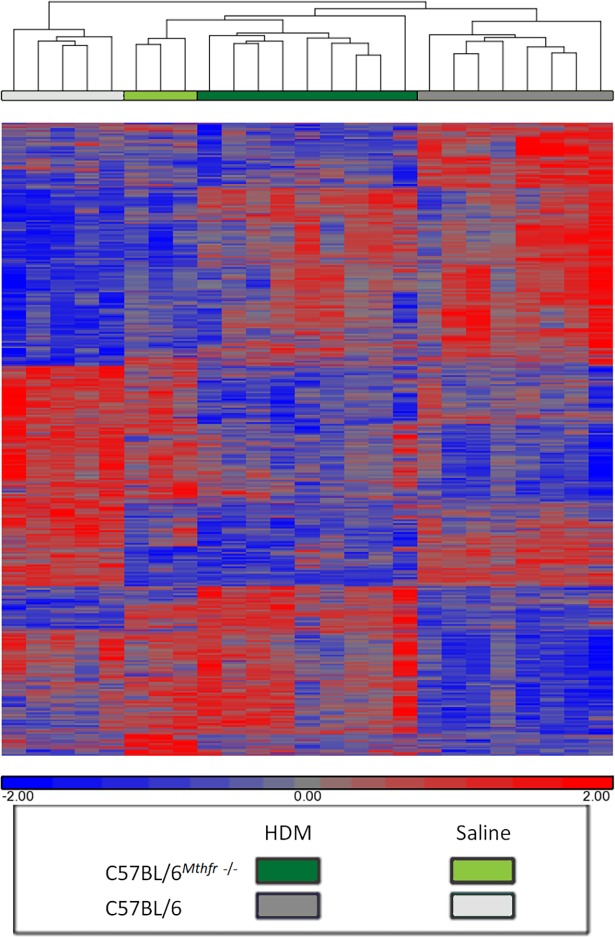
Hierarchal clustering of differentially expressed genes between HDM-treated C57BL/6Mthfr-/- and HDM-treated C57BL/6.ANOVA analysis identified 2,588 transcripts that are differentially expressed between the four experimental groups. Gene clustering by similarity in expression as quantified by the Pearson correlation using average linkage hierarchical clustering show groups of genes related to Mthfr status as well as treatment dependent clusters.